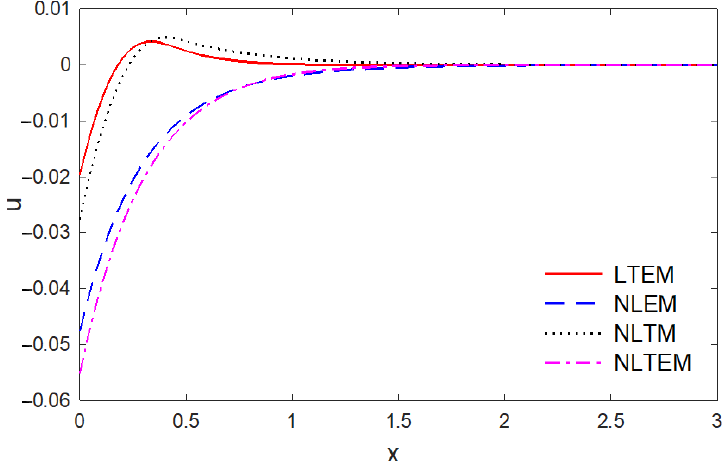
Figure 2. The displacement variations via the distance for four different models.